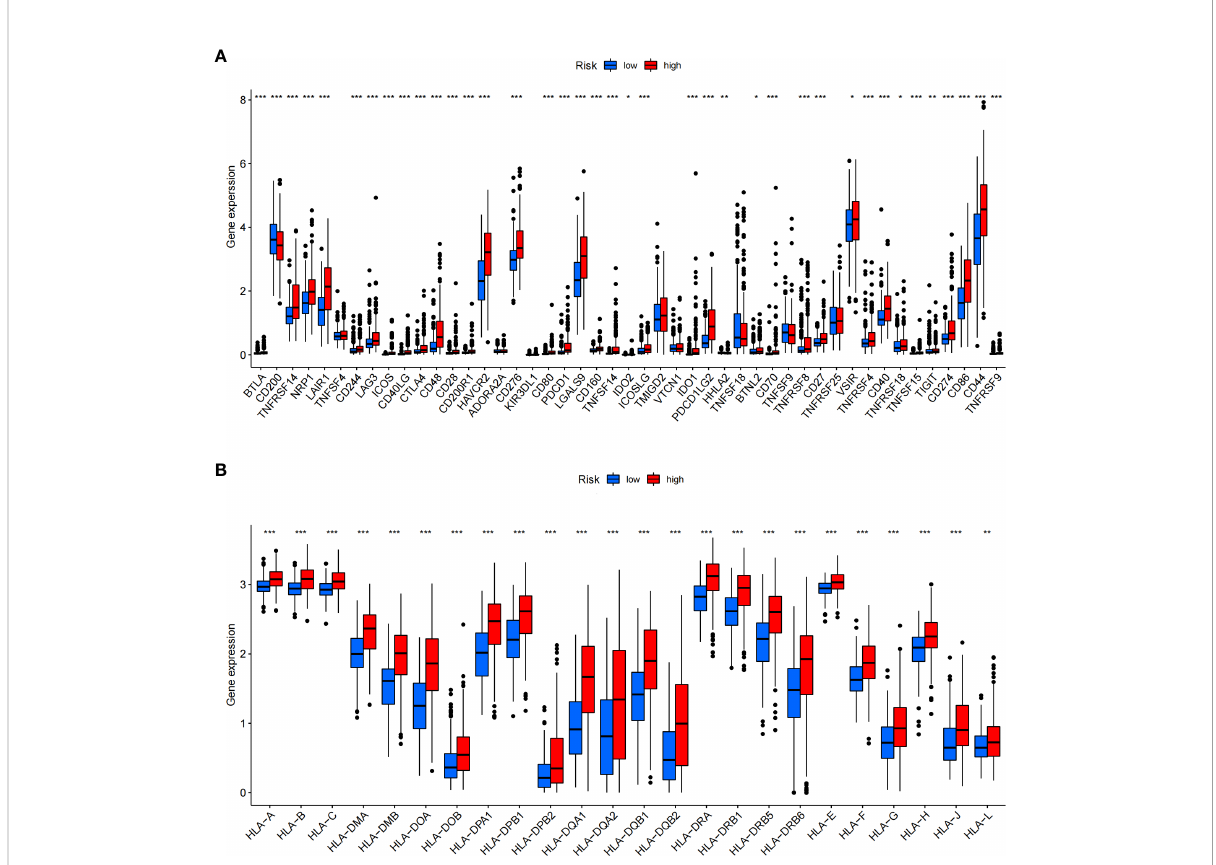
FIGURE 10 Differential expression of immune checkpoints and HLA genes. (A, B) Box plots of differentially expressed immune checkpoints (A) and HLA genes (B) between the ICD-high and ICD-low risk groups. *P < 0.05, **P< 0.01, ***P <